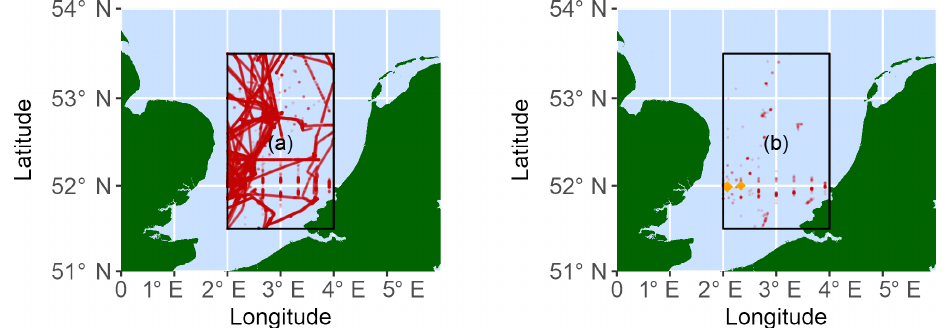
Figure 11. Illustration of potential numerical, geographical, and depth biases associated with data source in the southern North Sea from the